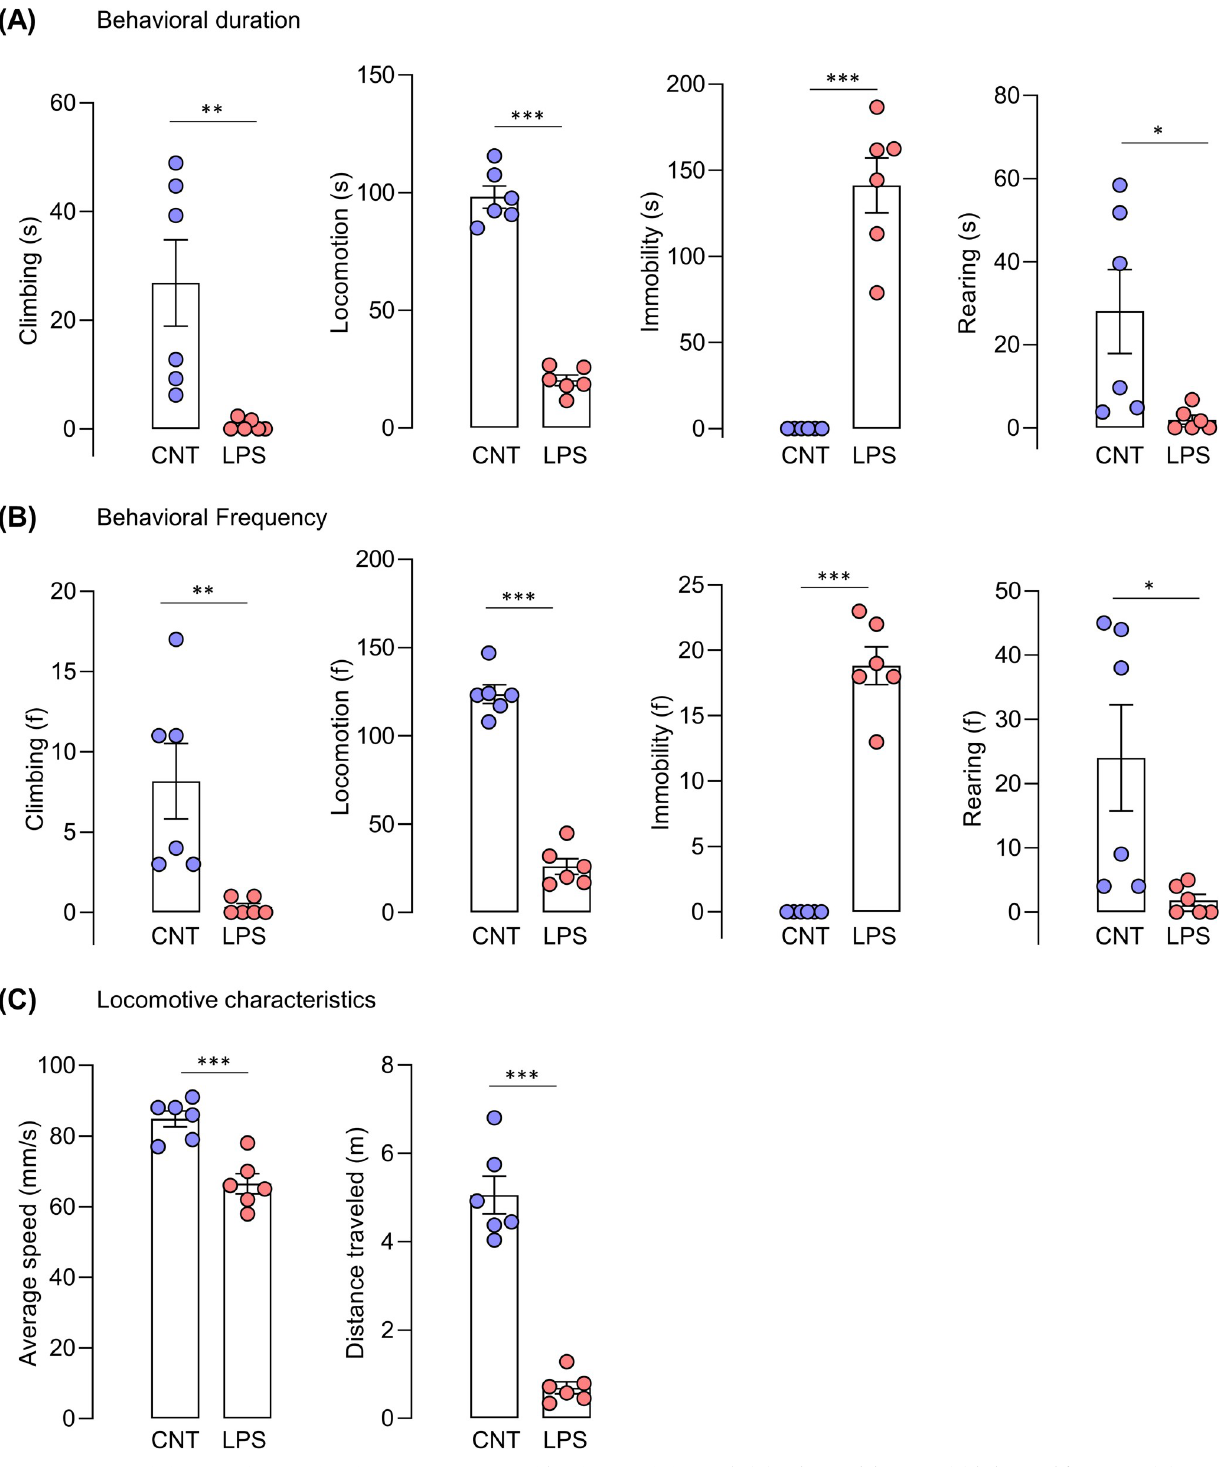
Fig 5. Home-cage behaviors of LPS-induced mice in 5-min period (exploratory behaviors). (A) Behavioral duration, (B) behavioral frequency, (C) locomotive characteristics. Unpaired t-test, N = 6 mice per group; � p < 0.05, �� p < 0.01, ��� p < 0.001 compared with the control group.